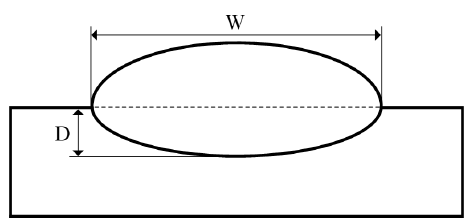
Figure 3. Schematic showing the dimensions of the melt pool. W and D represent the width ( µ m) and depth ( µ m), respectively.